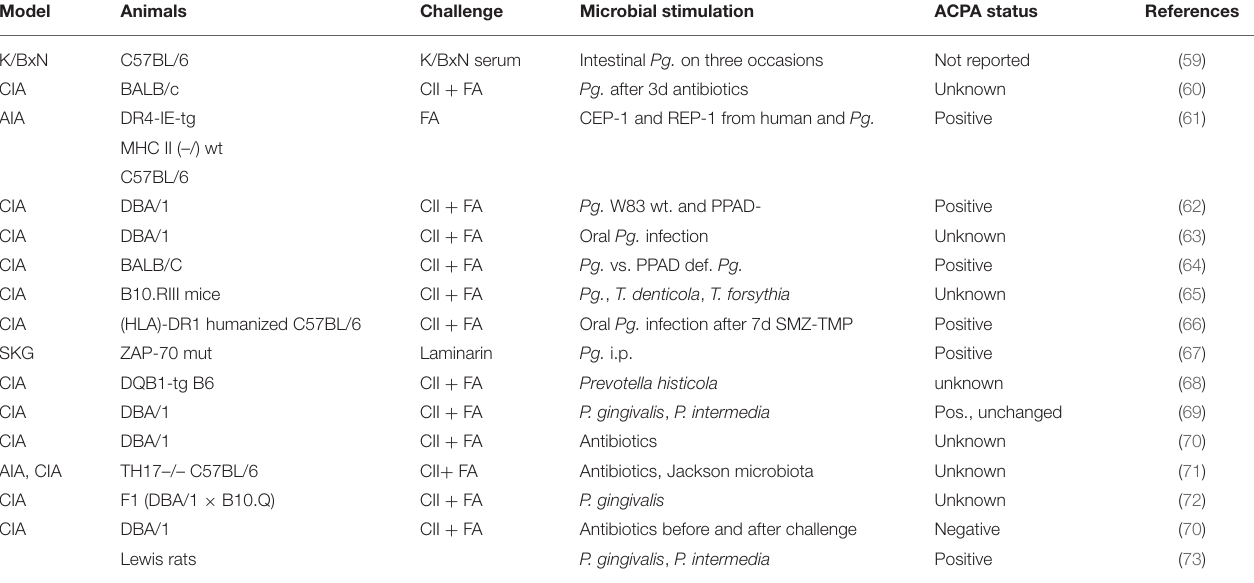
TABLE 1 | Mucosal inflammation in arthritis